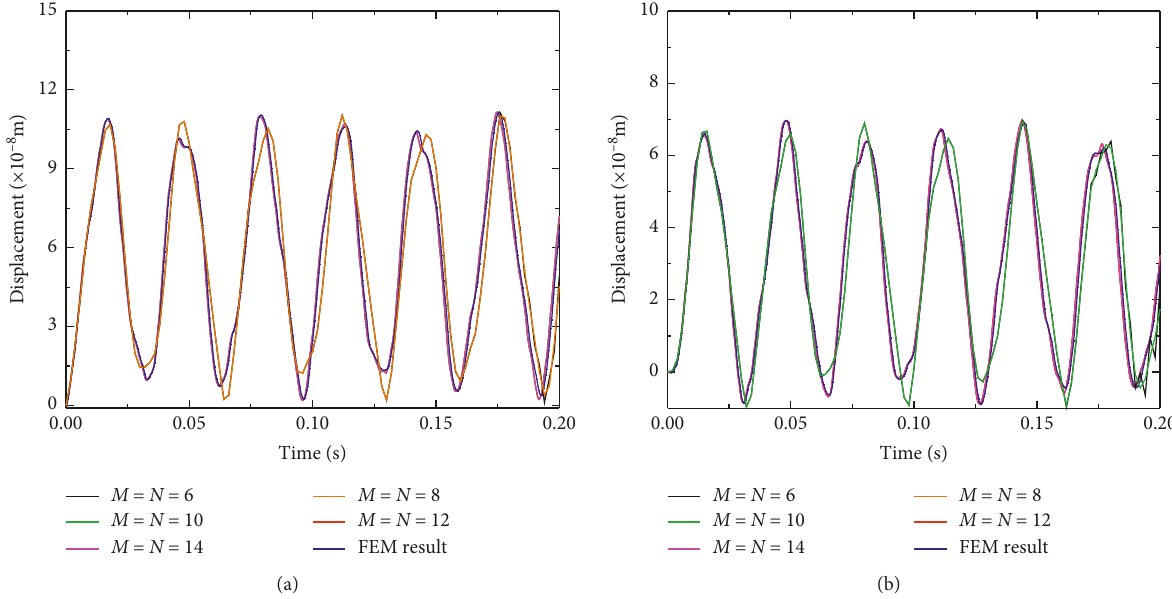
Figure 14: Convergence of transient responses for rectangular plate with one central x -wise beam and one central y -wise beam under local uniform pressure ( p w � 1). (a) Point A (1 m, 0.5m). (b) Point B (0.5m, 0.5 m).